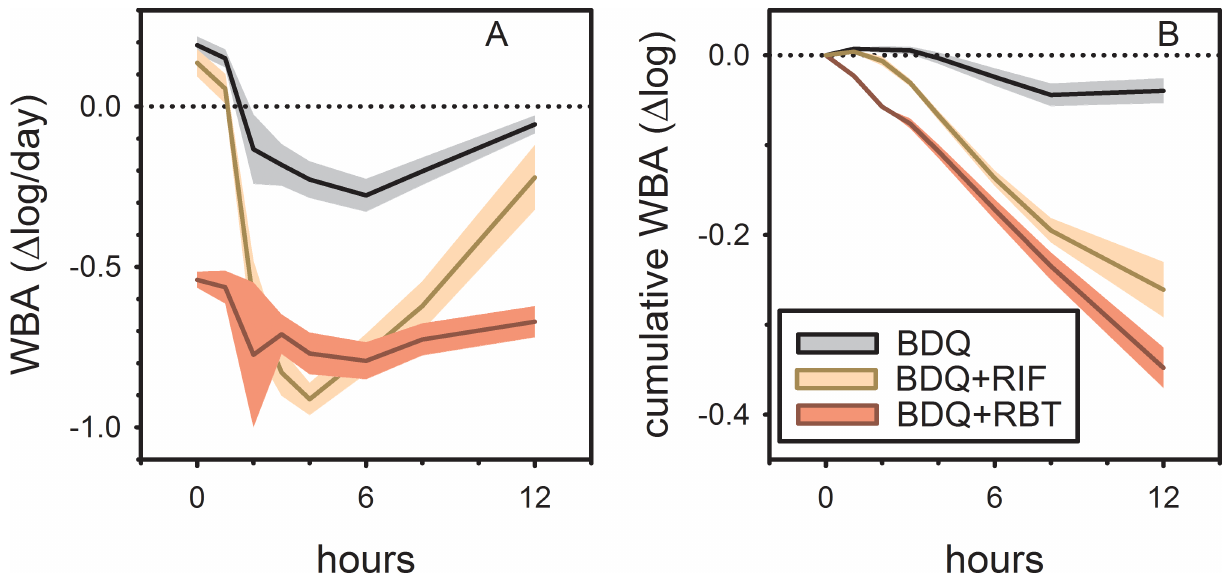
Fig 2. Mycobactericidal activity of single 400 mg doses of bedaquiline in ex vivo whole blood culture (WBA) in healthy volunteers, alone (gray), or combined with either rifabutin 300 mg (RBT, red) or rifampin 600 mg (RIF, yellow), after 9 days of rifamycin dosing. Panel A shows change in viability from beginning to end of each whole blood culture, expressed as log change per day of culture; panel B shows cumulative or total activity over the 12 hours following drug administration. Lines indicate mean values; shading indicates 90% confidence intervals.